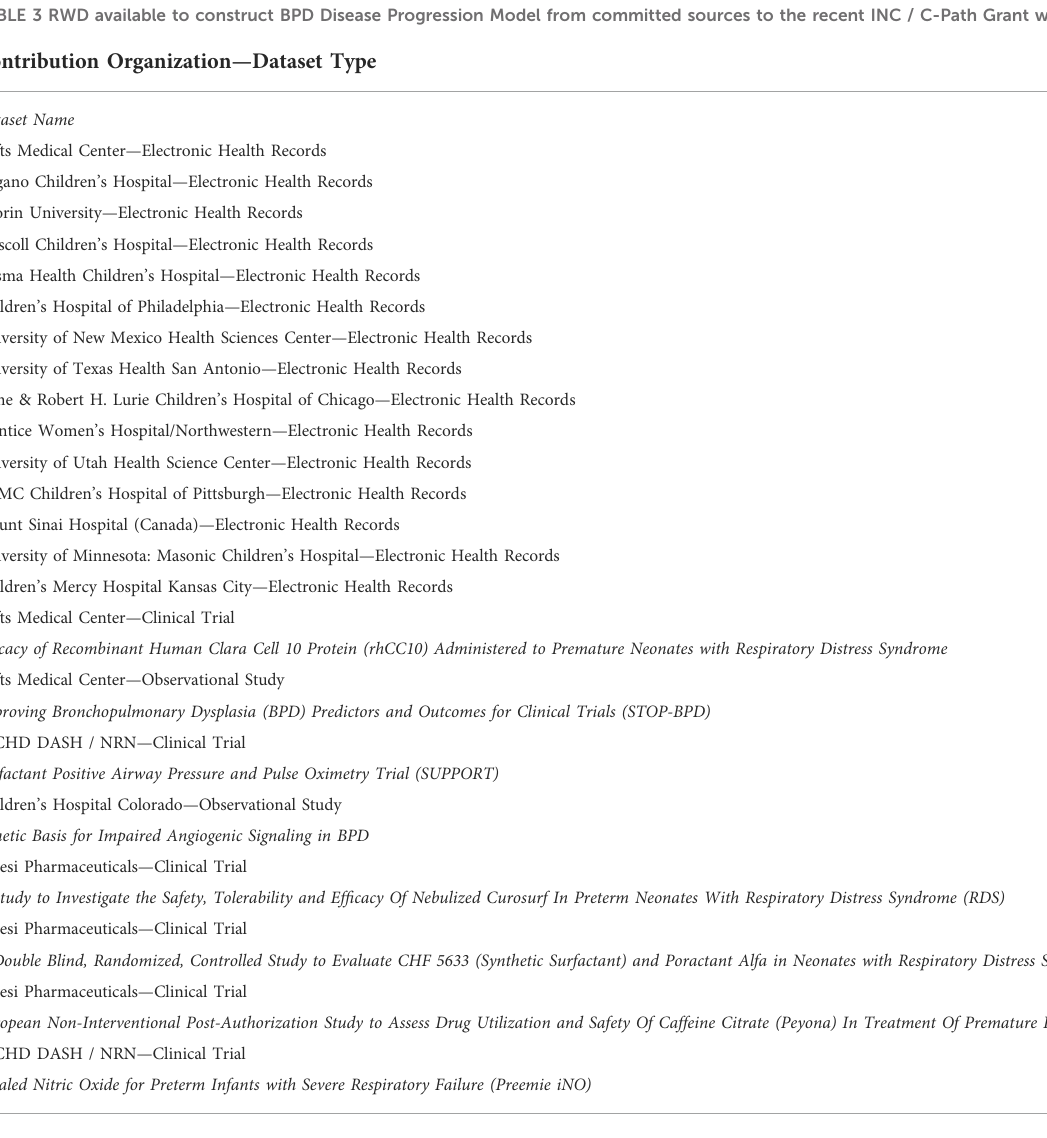
TABLE 3 RWD available to construct BPD Disease Progression Model from committed sources to the recent INC / C-Path Grant with